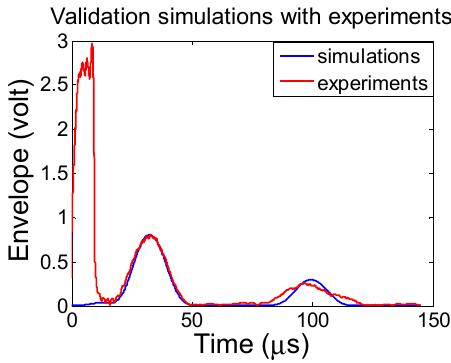
Figure 10. The envelope of the received signals. The blue curve and the red curve are the envelope of the received signal from simulations and experiments, respectively.